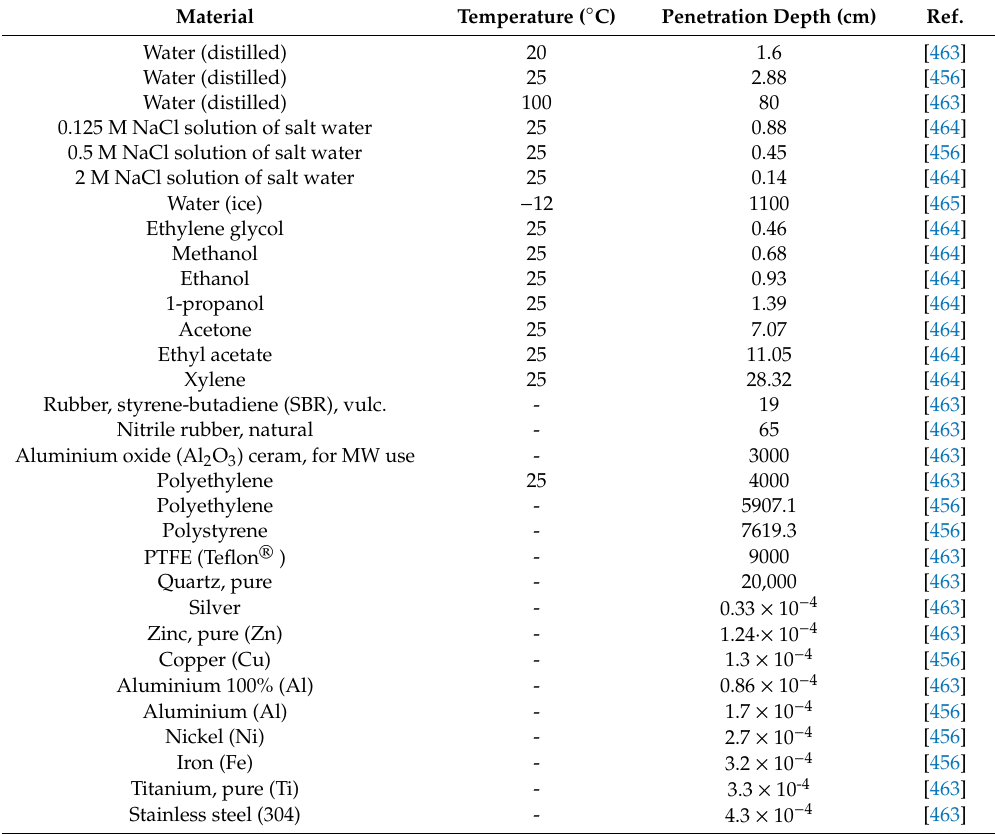
Table 3. Penetration depths of the 2.45 GHz microwaves for common solvents and